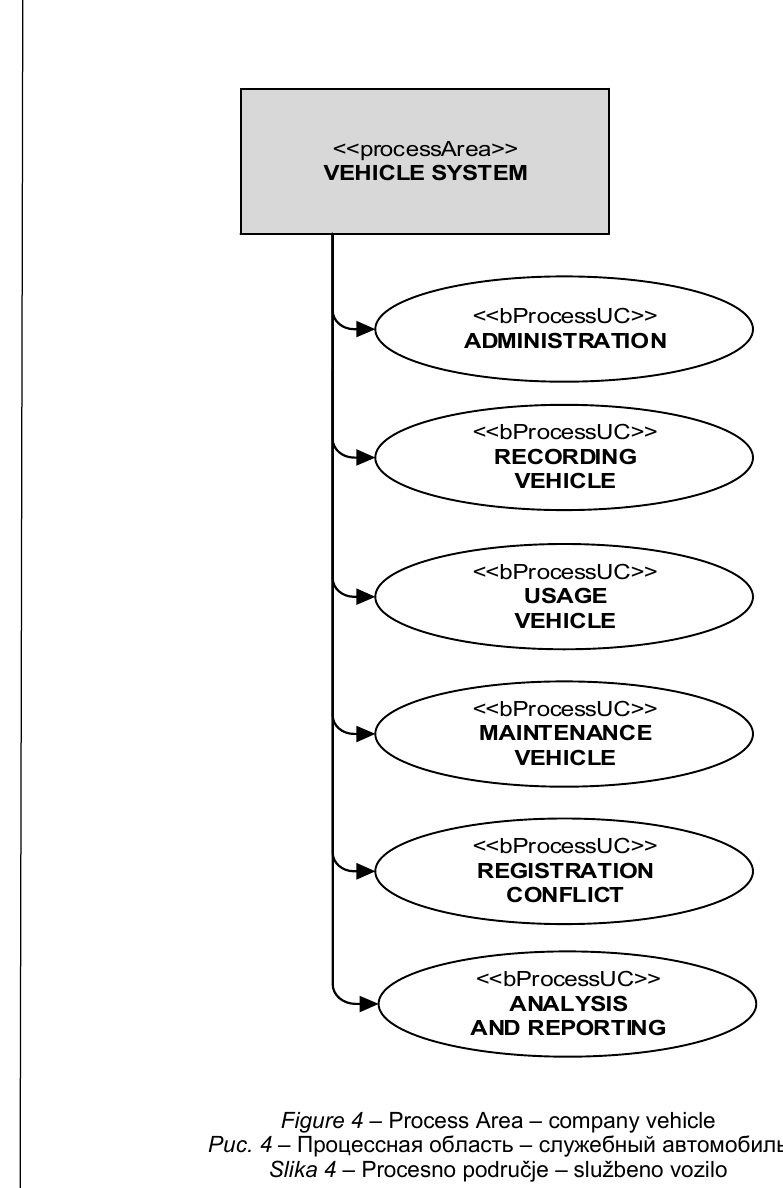
Figure 4 – Process Area – company vehicle Рис . 4 – Процессная область – служебный